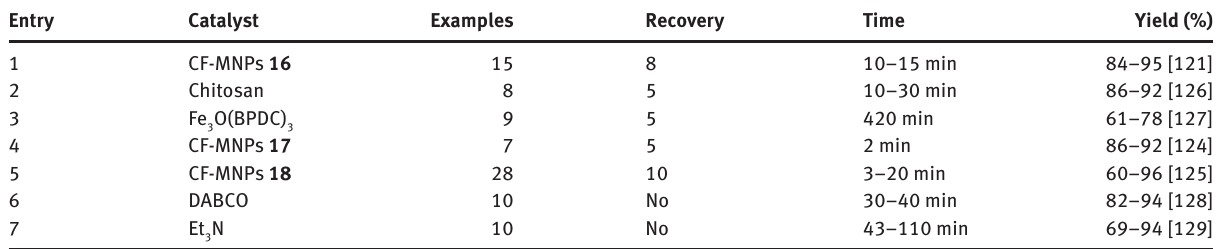
Table 8: Comparison of the activity of CF-MNPs catalysts with other reported catalysts in synthesis of pyridines (entries 1–3), and pyrans (entries